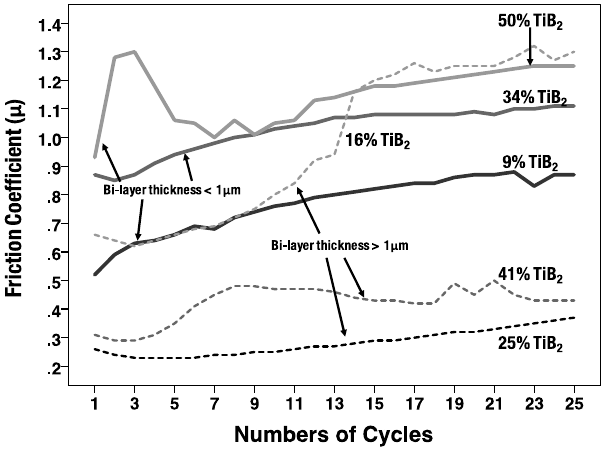
Figure 3. Bi-directional wear test performed at a constant load of 10 N for the two sets of coatings. The solid lines are for the multilayer coatings with a bilayer thickness >1 μ m and the dashed lines are for the multilayers where the bilayer thickness is <1 μ m.